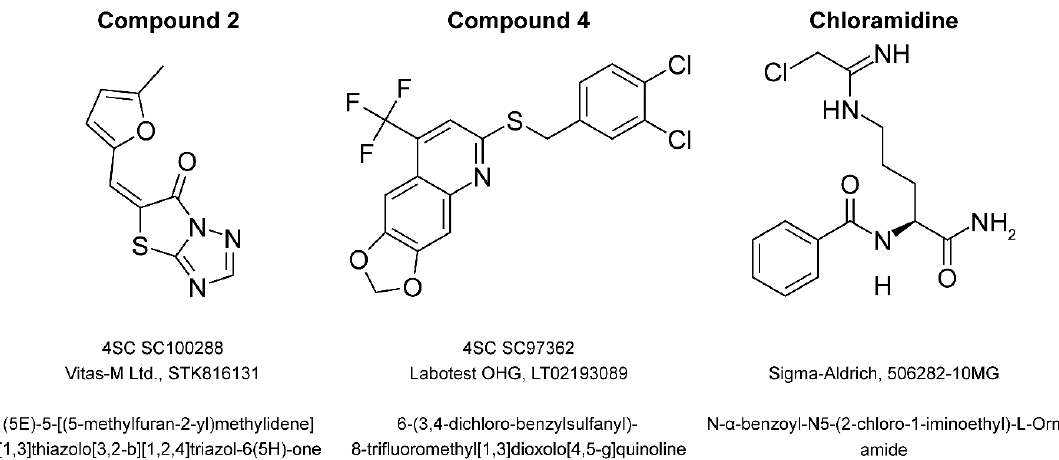
Figure 6. Structures of the commercially available compounds: compound 2 , 4 , and Cl-amidine. Individual compounds are identified by 4SC internal ID number and manufacturer catalog number. Chemical names are provided. Table 2. List of the tested compounds.